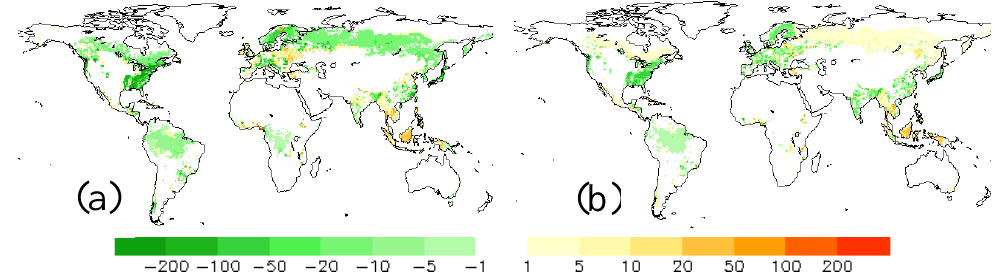
Figure 6. Spatial distributions of the net exchange of carbon (gC/m 2 /yr) for the 1990s in secondary forests for (a) ISAM-C and (b) ISAM-NC. C fluxes estimated based on ISAM-C version of the model are not constrained by N dynamics, whereas ISAM-NC based C fluxes are constrained by the N dynamics. Positive values represent net C release to the atmosphere and negative values represent net C storage in terrestrial biosphere.